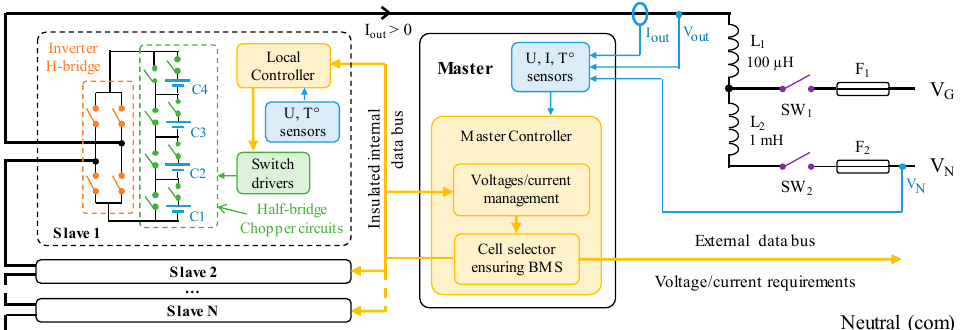
Figure 2. High Frequency Self-Reconfigurable Battery (HF SRB) hardware architecture.